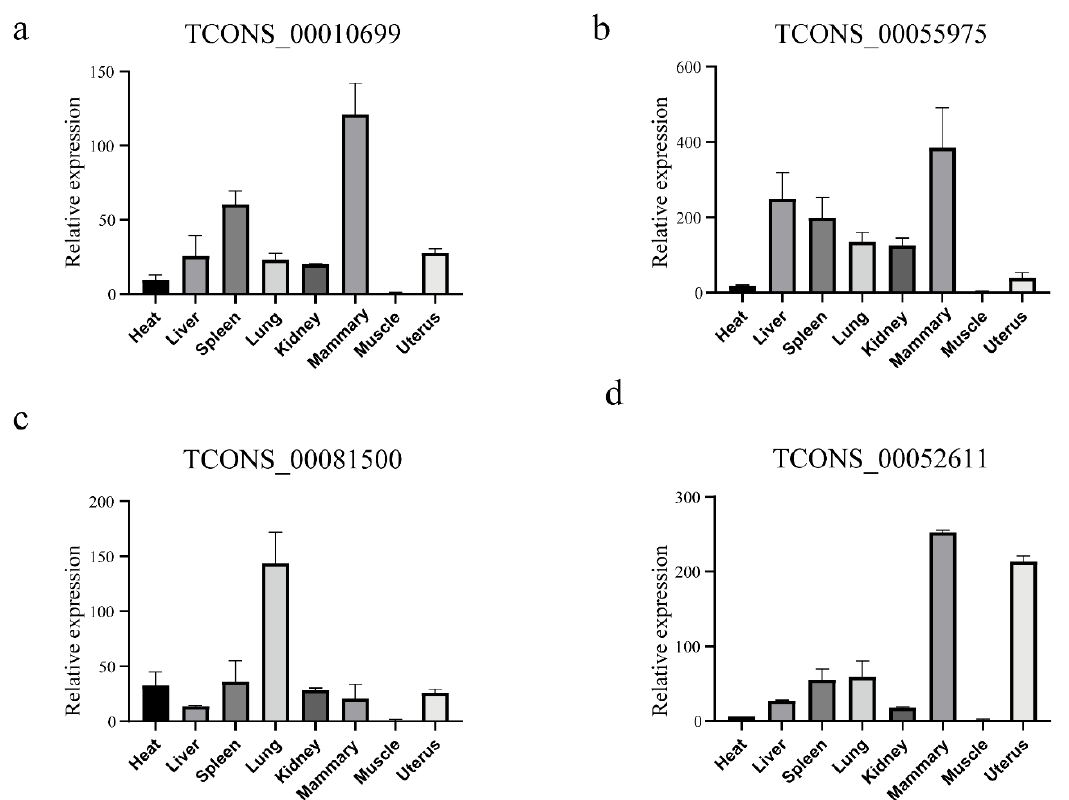
Figure 2. ( a – d ) Expression profile of four putative long intergenic non-coding RNAs (lincRNAs) in eight different tissues. Y axis represents relative expression level. Results are presented as mean values ± Standard error (SEM).